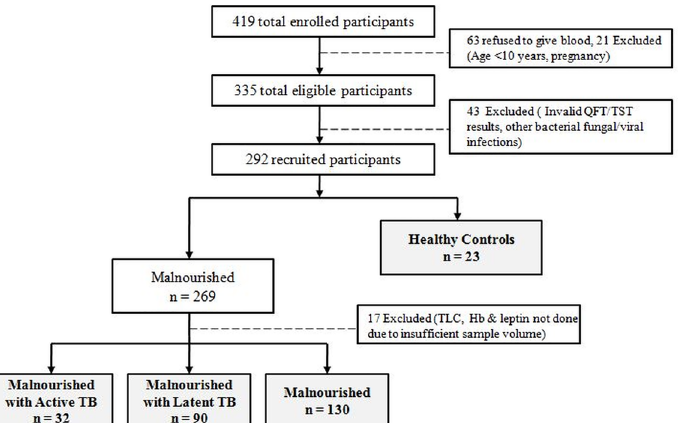
Fig 2. Study participation diagram. The figure represents the inclusion/exclusion criteria adopted for recruitment of the study population. The population was categorized into four groups namely: Malnourished group with Active TB (n = 32), Malnourished group with Latent TB (n = 90), Malnourished group (n = 130) and Healthy control group (n = 23) (Grey boxes indicate the groups included in the final analysis). TB-Tuberculosis, TST-Tuberculin Skin Test, Cut-off point is atleast 10 mm, QFT- QuantiFERON-TB Gold, Cut-off is atleast 0.35 IU/ μ l. TLC-Total leukocyte count, Hb-Hemoglobin count (g/ml)